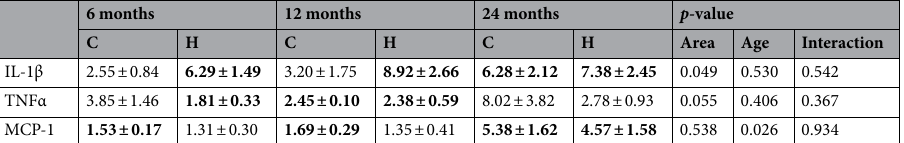
Time-dependent brain expression profile analysis of IL-1β and TNFα cytokines, and of MCP-1 chemokine in AD (APPswe/PS1dE9) mouse brain. To aid elucidate the neuroinflammatory environ- ment and differential involvement of the hippocampal and cortical regions, IL-1β, TNFα, and MCP-1 mRNA expression was analyzed in 6-, 12- and 24-month old AD Tg mice, with respect to age-matched WT mice. Our results demonstrate a generally lower elevated expression level of MCP-1 chemokine in AD vs . WT mice, as compared to the pro-inflammatory cytokines, IL-1β and TNFα (Table 2). These data were additionally con- firmed by normalizing the aged APP/PS1 (12 and 24 months) vs. APP/PS1 (6 months) assumed as the calibrator. This additional analysis allowed us to exclude the influence of physiological aging in WT mice, on gene expres- sion variation (data not shown). Interestingly, IL-1β and TNFα were significantly and substantially increased in the hippocampus at the early 6 month time point in AD Tg mice, with respect to WT mice. In hippocampus, this elevated expression of both pro-inflammatory cytokines remained significantly sustained. With respect to cortex IL-1β and TNFα expression, neuroinflammation seems to be delayed (in comparison to that evident in hippocampus) and peaked at 24 months. Changes in MCP-1 expression were largely similar in cortex and hip- pocampus, and were relatively modest at 6 and 12 months of age (albeit reaching statistical significance in the cortex). However, MCP-1 expression was substantial and reached its highest level at 24 months of age, in both hippocampus and cortex. Moreover, in linear mixed models that adjusted for the effect of age and the interaction between age and brain areas, a statistically significant difference between areas was detected for IL-1β expression (p = 0.049) (Table 2). Conversely, in the same models adjusting for the effect of brain areas and the interaction between age and areas,